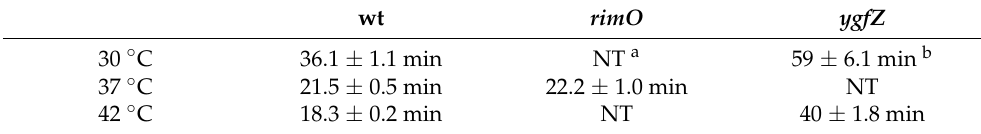
Table 1. Generation times of the bacterial strains at different growth temperatures.